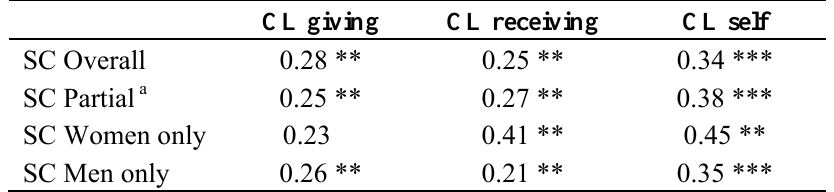
Table 2. Pearson’s correlations between spiritual coping (SC) and compassionate love (CL): overall, partial a , women only, and men only. CL